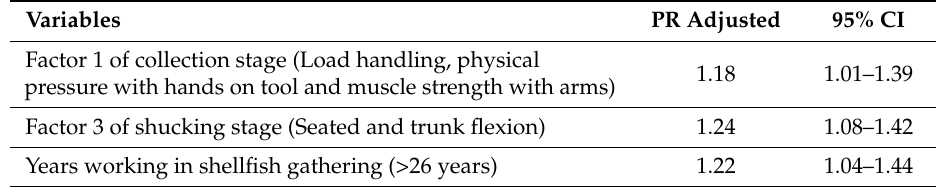
Table 5. Multivariate analysis of the adjusted Prevalence Ratio for lower back MSD and variables